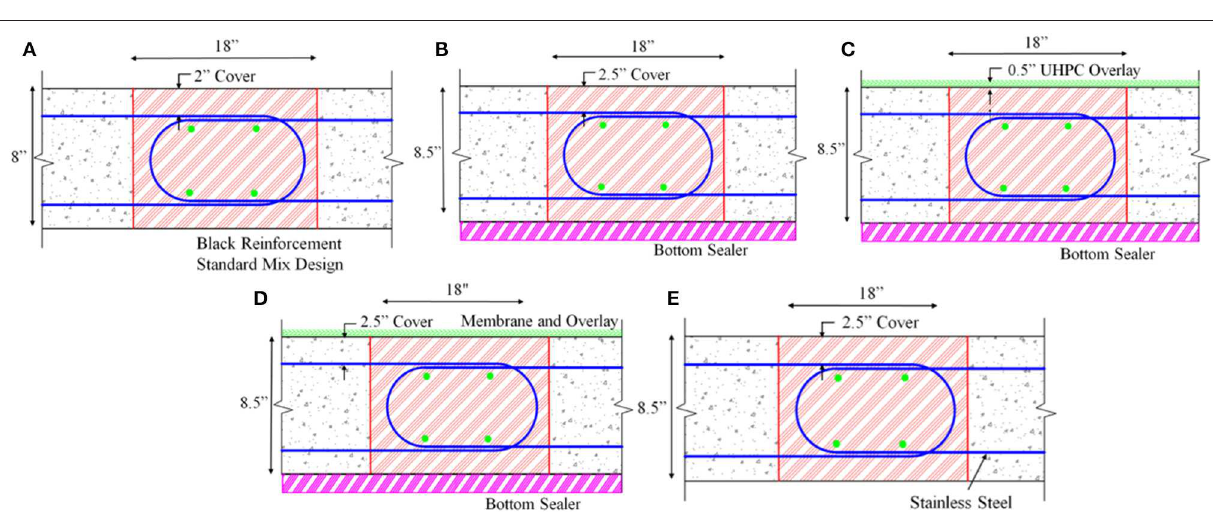
Figure 10A . The joint width for this alternative is 18